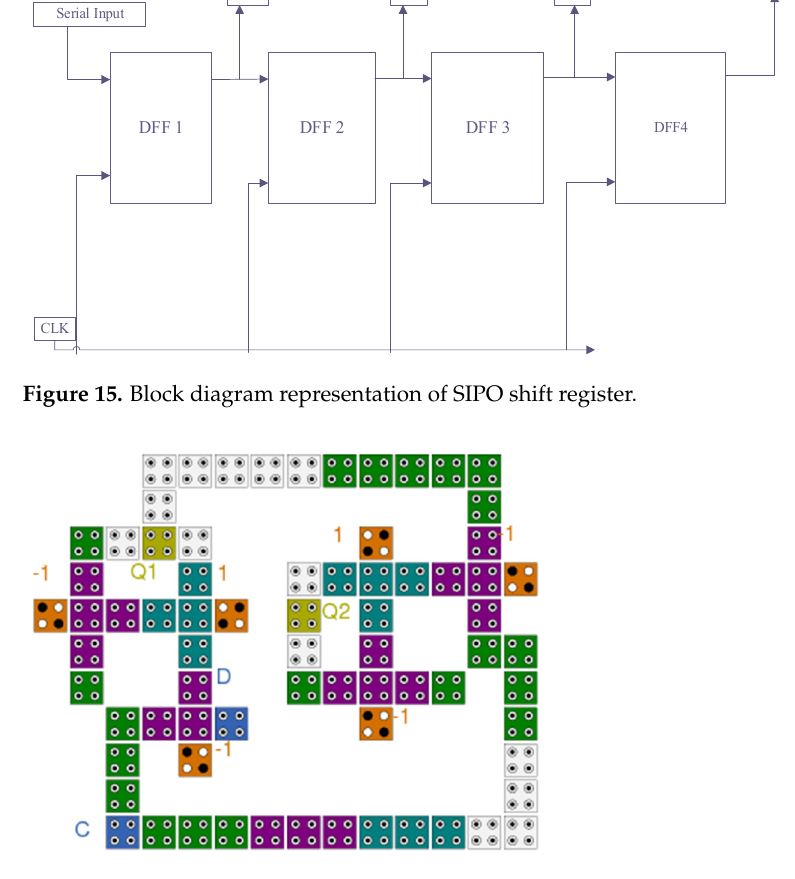
Figure 16. QCA Implementation of 2-bit SIPO shift register.